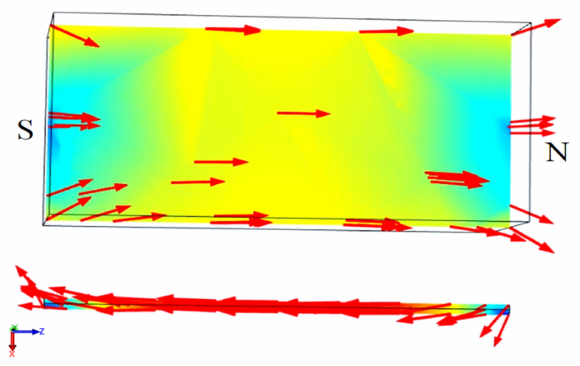
Figure 5. Magnetic field line simulation for a magnet parallel to a Wiegand wire.